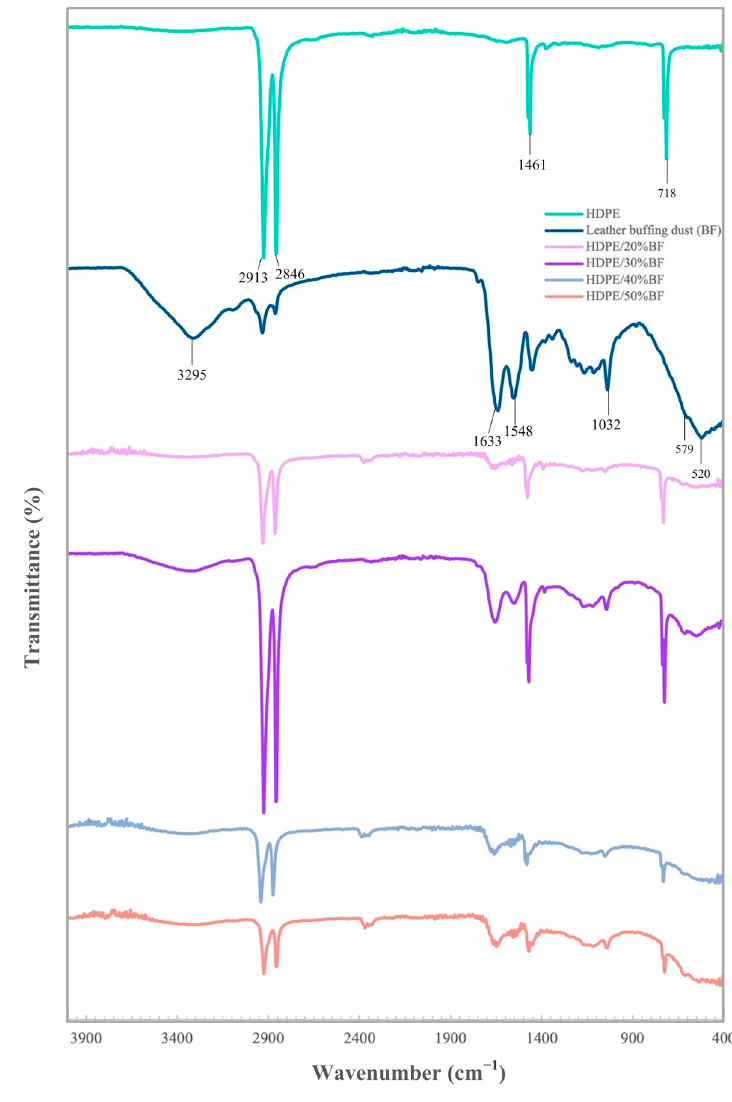
Figure 4. FTIR spectra of leather BF, HDPE and 20%, 30%, 40%, and 50% BF